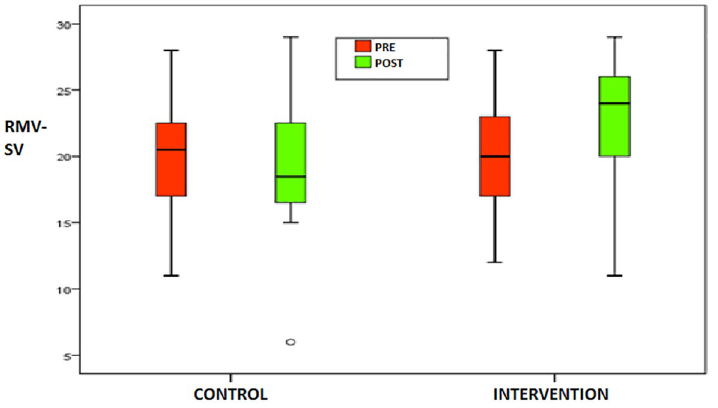
Fig 4. RMV-SV results for both control and intervention group. The left part of the figure represents RMV-SV scores of the control group and the right part represents the RMV-SV scores of the intervention group. The red and green boxes contain the fifty per cent of the results of the RMV-SV scores pre and post-intervention in the different groups. Whiskers indicate the extreme scores of the RMV-SV